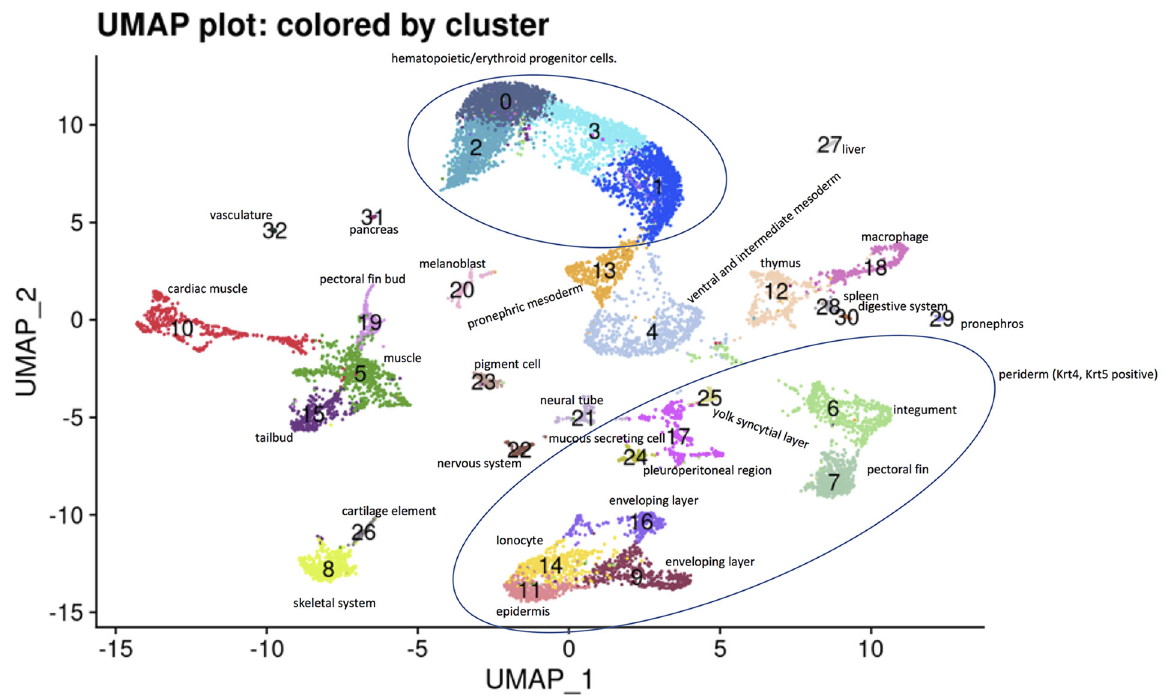
Figure 1: Cell type assignments. A UMAP plot was generated and the clusters were assigned a cell type based on the most differentially expressed genes in each